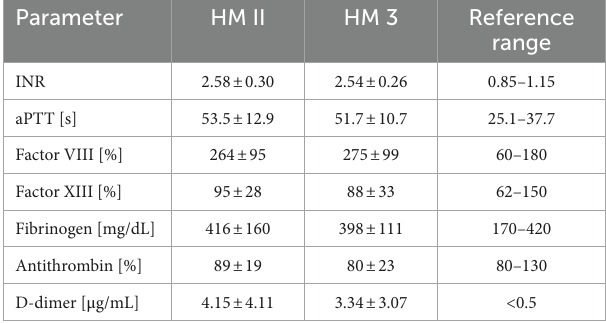
TABLE 2 Routine coagulation of HM II ( n = 16), HM 3 ( n = 12) patients on long-term support.